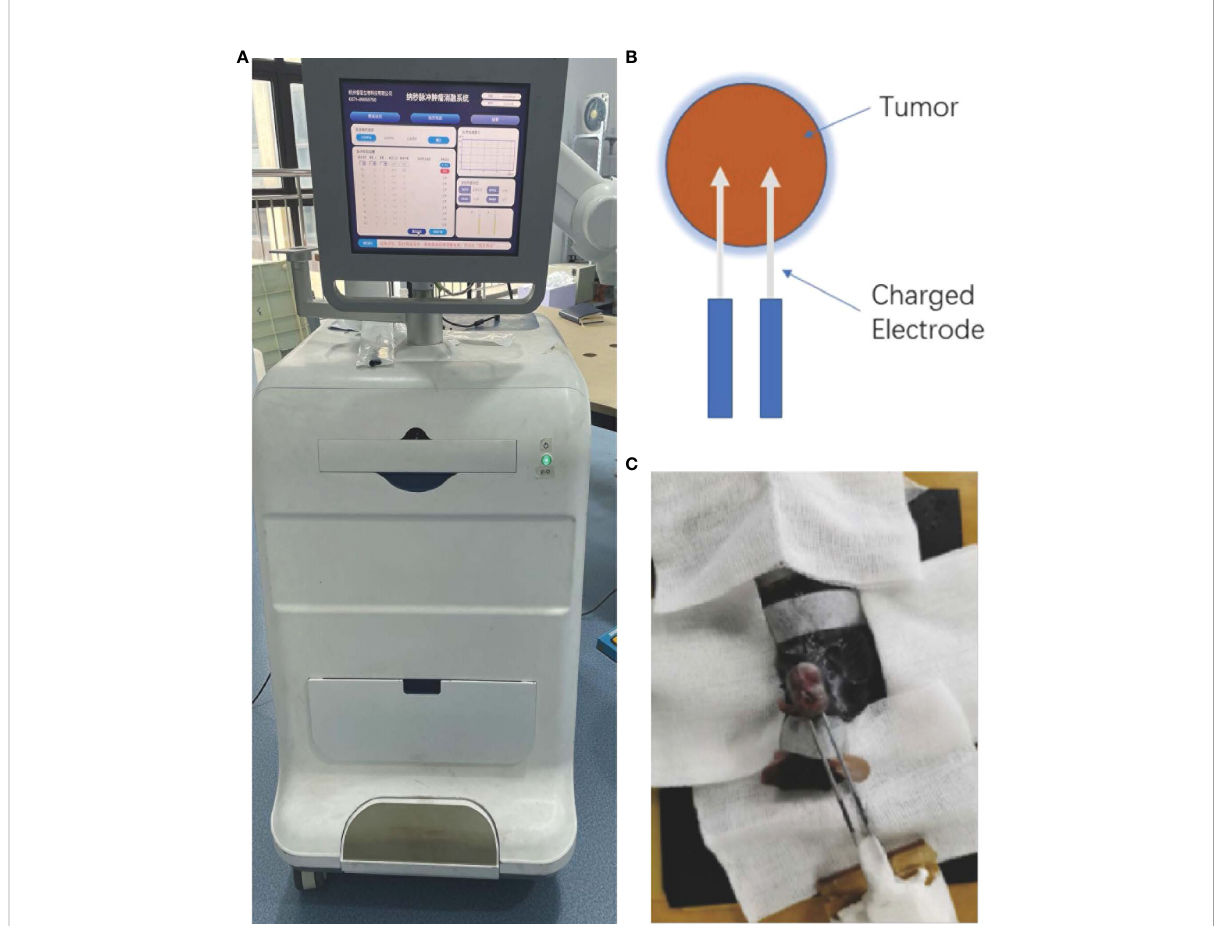
FIGURE 1 (A) Image of the nanosecond-pulsed tumor ablation system. (B) Schematic illustration of the treatment strategy. (C) Representative photograph showing nsPEFs electrode placement within the targeted